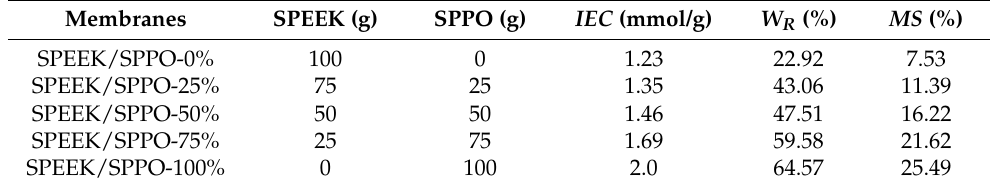
Table 1. Composition, ion exchange capacity, water uptake and swelling ratio of SPEEK/SPPO-0 to SPEEK/SPPO-100 membranes (where 0, 25, 50, 75 and 100% represent the amount of SPPO into the SPEEK/SPPO blended membranes).